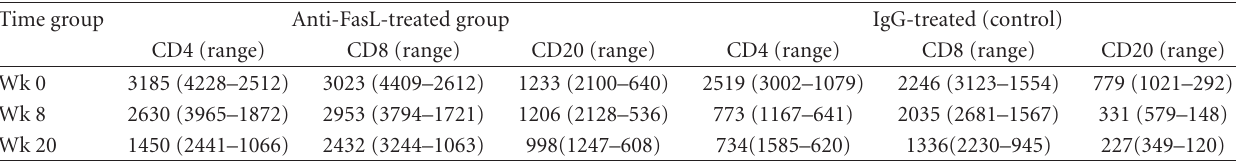
Figure 1: The anti-FasL monoclonal antibody blocks MHC-unrestricted cytolysis and stains FasL on rhesus PBMC. (Panel A) Anti-FasL, the humanized NOK2 monoclonal (RNOK203), blocked MHC-unrestricted cytolysis in vitro using rhesus or human PBMC as e ff ectors and human or rhesus B-LCL targets that expressed SIV envelope glycoprotein (transfected with pCDNA3/SIVenv). The four-hour chromium- release assay was done in the presence of 1mM EGTA and varying amounts of anti-FasL at an E : T ratio of 50 : 1 as described [23]. Specific lysis was blocked completely at 20 μ g/mL of monoclonal antibody (shown) and not with a similar concentration of isotype control antibody (not shown). When no e ff ector cells were added (No E), there was no specific lysis showing that 20 μ g/mL anti-FasL does not induce cell death on its own. These experiments were done 3 times with rhesus PBMC, 3 times with human PBMC, and 2-3 times cross species with the same results. The error bars represent the variation in 3 di ff erent experiments using rhesus cells. (Panel B) MHC-unrestricted cytolytic activity correlated with the mean fluorescence intensity (MFI) of cell surface FasL on circulating PBMC. PBMC specimensfrom rhesus macaques were screened by the MHC-unrestricted cytolysis assay as described [23]. Results from 10 rhesus macaques are shown here. Macaques were divided into high ( ≥ 15% specific lysis) and low ( < 10% specific lysis) groups, and stained with the anti-FasL antibody in an indirect immunofluorescence assay. The individual points, mean values, and standard deviations are shown for animals classified as having low or high cytolytic activity. Macaques with high levels of MHC-unrestricted cytolytic activity and correspondingly high levels of cell surface FasL were selected for this study. Table 2: Absolute lymphocyte cell counts. Absolute cell counts are given as cells per microliter of blood. Each number is the average of the absolute counts for 4 animals. The counts in parentheses reflect the range of counts seen in 4 animals at that time point. Time is given in weeks from the start of antibody treatment. Week 0 is the lymphocyte count on the first day of treatment, taken before the inoculation with